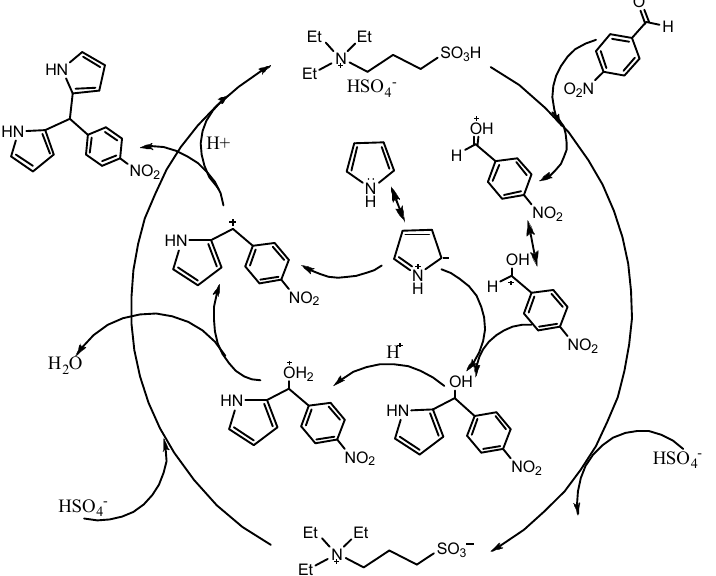
Figure 8. Mechanism of the 2,2′-(4-nitrophenyl) dipyrromethane synthesis with the use of the [TEAPS][HSO 4 ] ionic liquid catalyst.